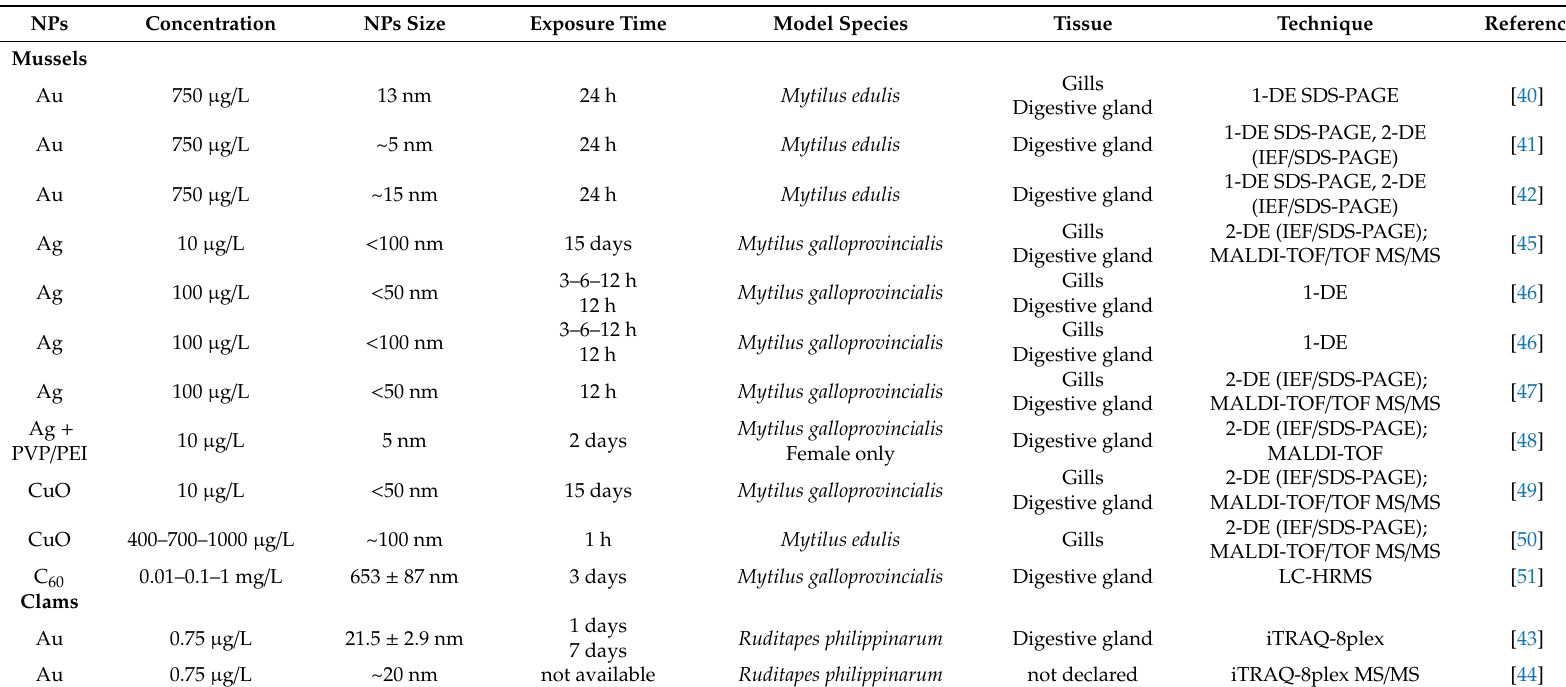
Table 1. List of proteomic studies performed on marine bivalves, mussels and clams, to investigate changes in protein profile due to the exposure to di ff erent nanoparticles